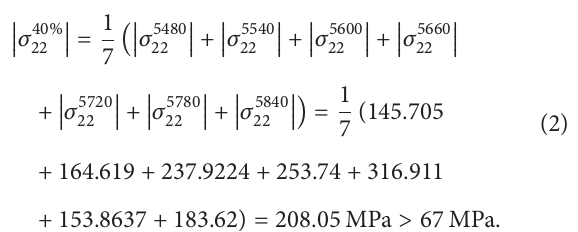
analysis of bimetallic bush looks as a whole when